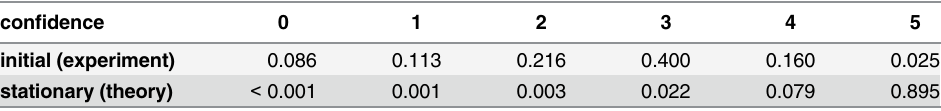
Table 1. Frequencies of confidence levels. First line: as measured in the first round of the experiment. Sec- ond line: theoretical stationary values. con fi dence 0 1